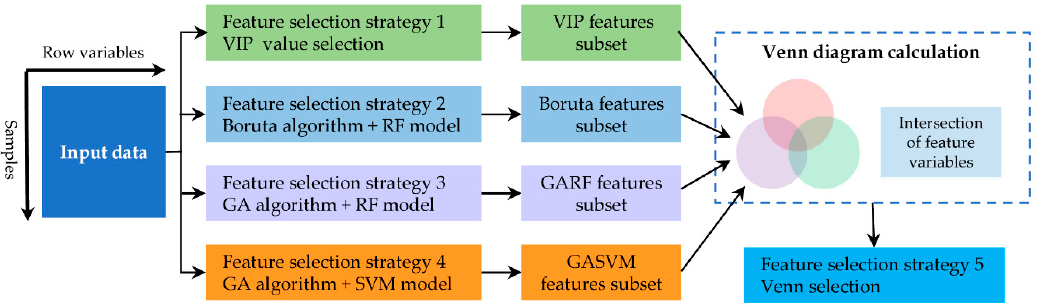
Figure 6. Feature selection strategies in the study.